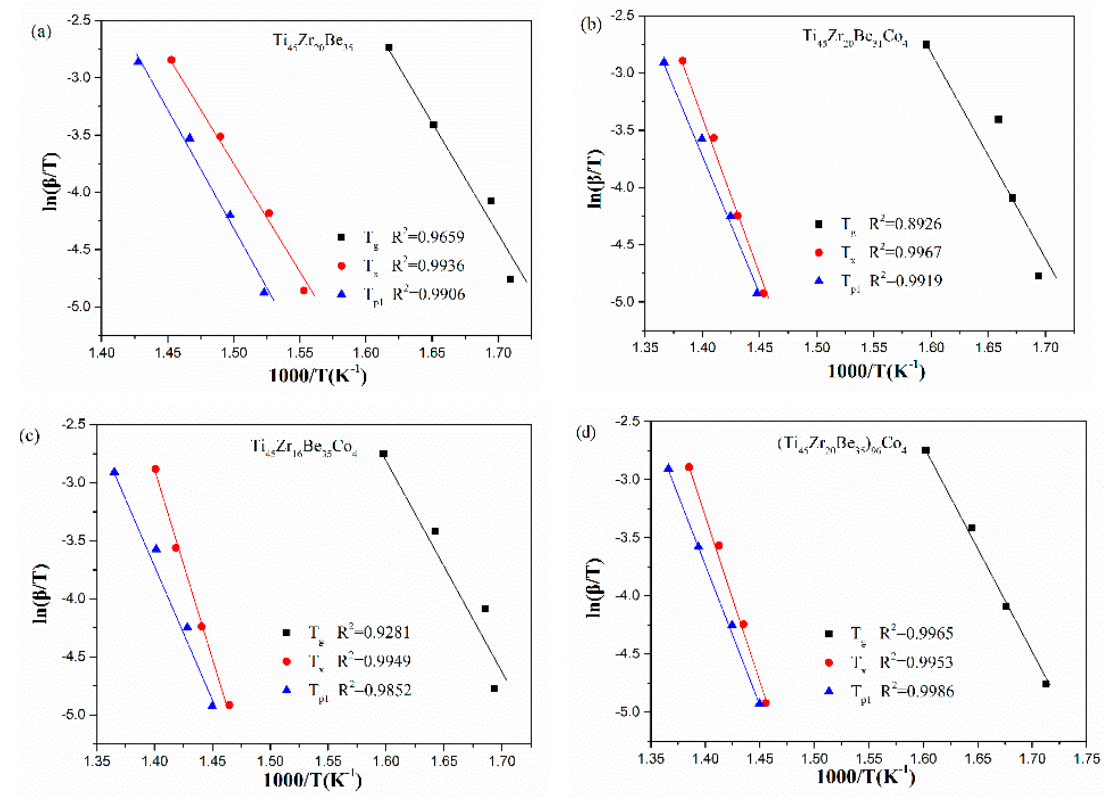
Figure 10. Moynihan (Ozawa) plots for ( a ) Ti 45 Zr 20 Be 35 , ( b ) Ti 45 Zr 20 Be 31 Co 4 , ( c ) Ti 45 Zr 16 Be 35 Co 4 , and ( d )